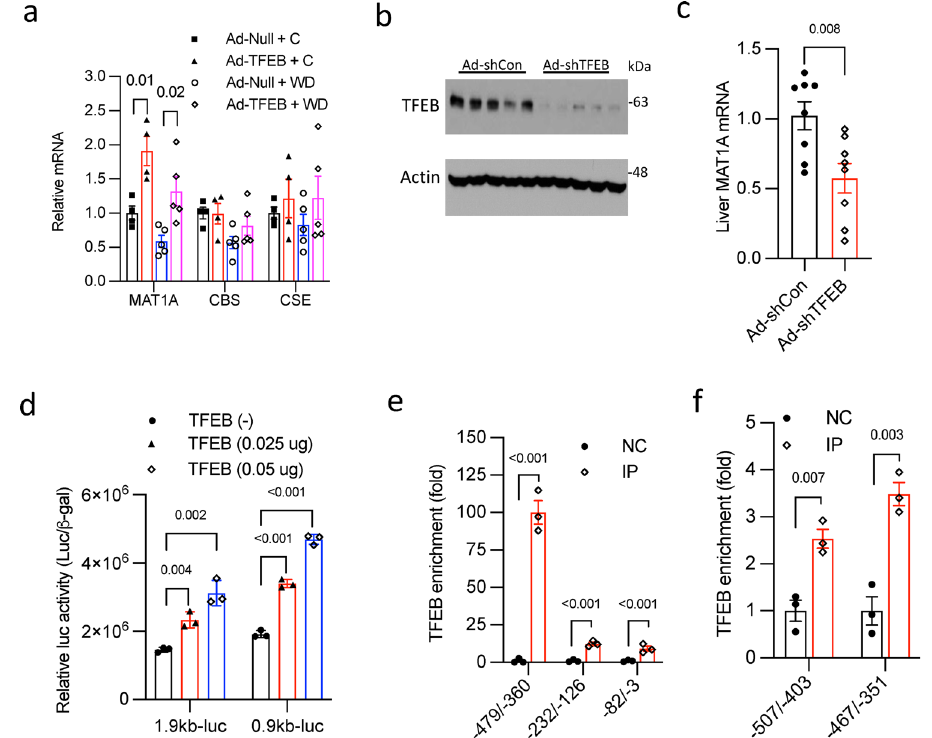
Fig. 3 | TFEBstimulation of MAT1A transcription. a Male 10 weeks oldC57BL/6J mice were intravenously injected with Ad-Null or Ad-TFEB at 5×10 8 pfu/mouse. One week later, mice were fed chow (C) or Western diet (WD) for one additional week.RelativelivermRNAareshownwithcontrolarbitrarilysetas1.( n =5).MAT1A Methionine adenosyltransferase 1A, CBS cystathionine β -synthase, CSE cystathio- nine γ lyase. b , c Male10weeksoldC57BL/6Jmicewereintravenouslyinjectedwith Ad-shCon (Ad-scramble) or Ad-shTFEB at 1X10 9 pfu/mouse. Mice were fed chow for 2 weeks and euthanized after 6h fast ( n =8). Liver protein ( b ) and mRNA ( c ) were measured. Each band represents an individual mouse sample in ( b ). d Luciferase reporter constructs containing 1.9kb or 0.9kb human MAT1A pro- moter and TFEB expression plasmids were transfected in triplicates in AML12 cells